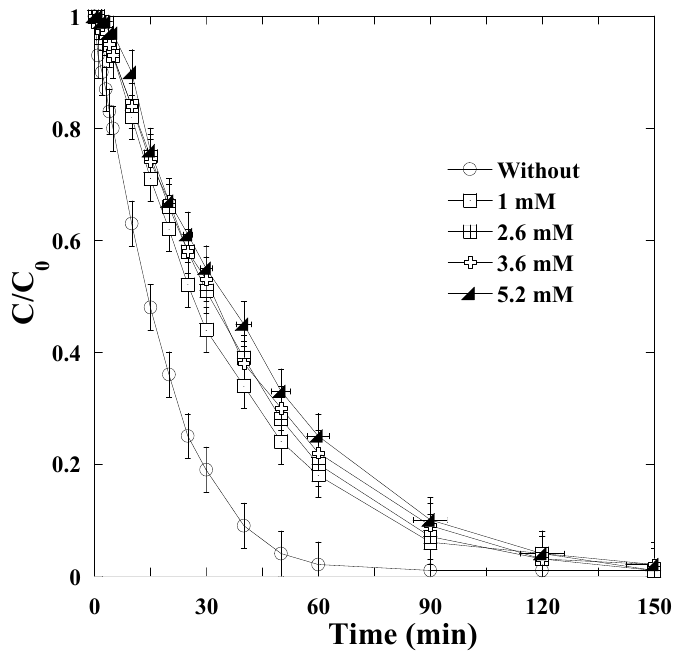
Figure 13. Effect of the addition of the tertbutanol on AO10 degradation ([AO10] 0 = 50 mg/L, 20 ± 1 ◦ C, [IO 4 − ] = 3 mM, irradiation intensity: 15 mW/cm 2 ).